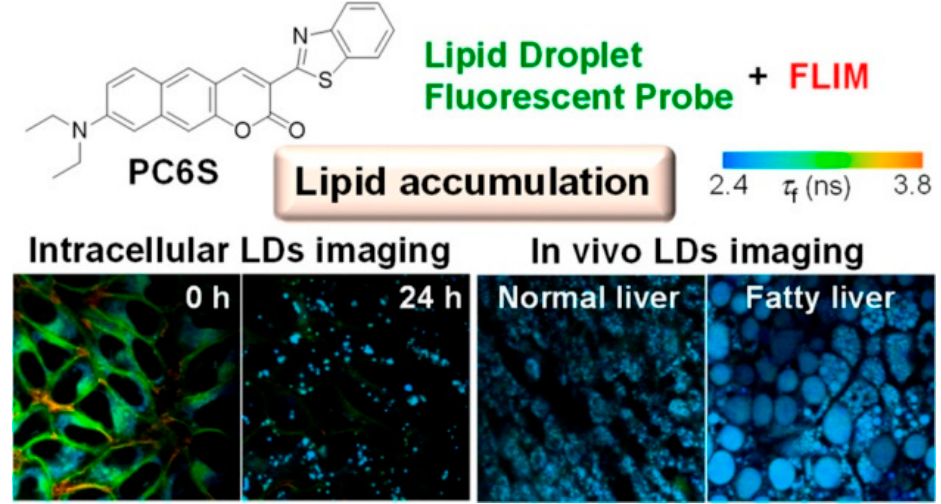
Figure 11. Structure of the probe PC6S for monitoring LD polarity and in vivo visualization of cells [41]. Copyright © 2023 American Chemical Society .